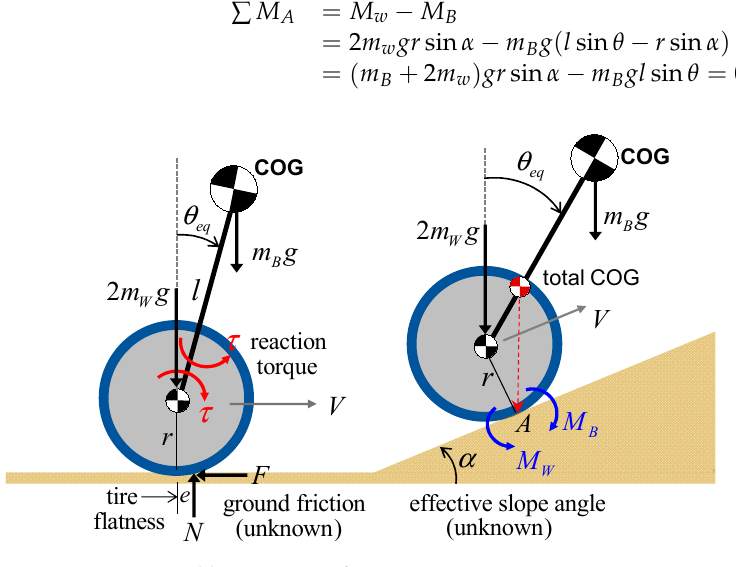
Figure 2. Static equilibrium state of TWIP.